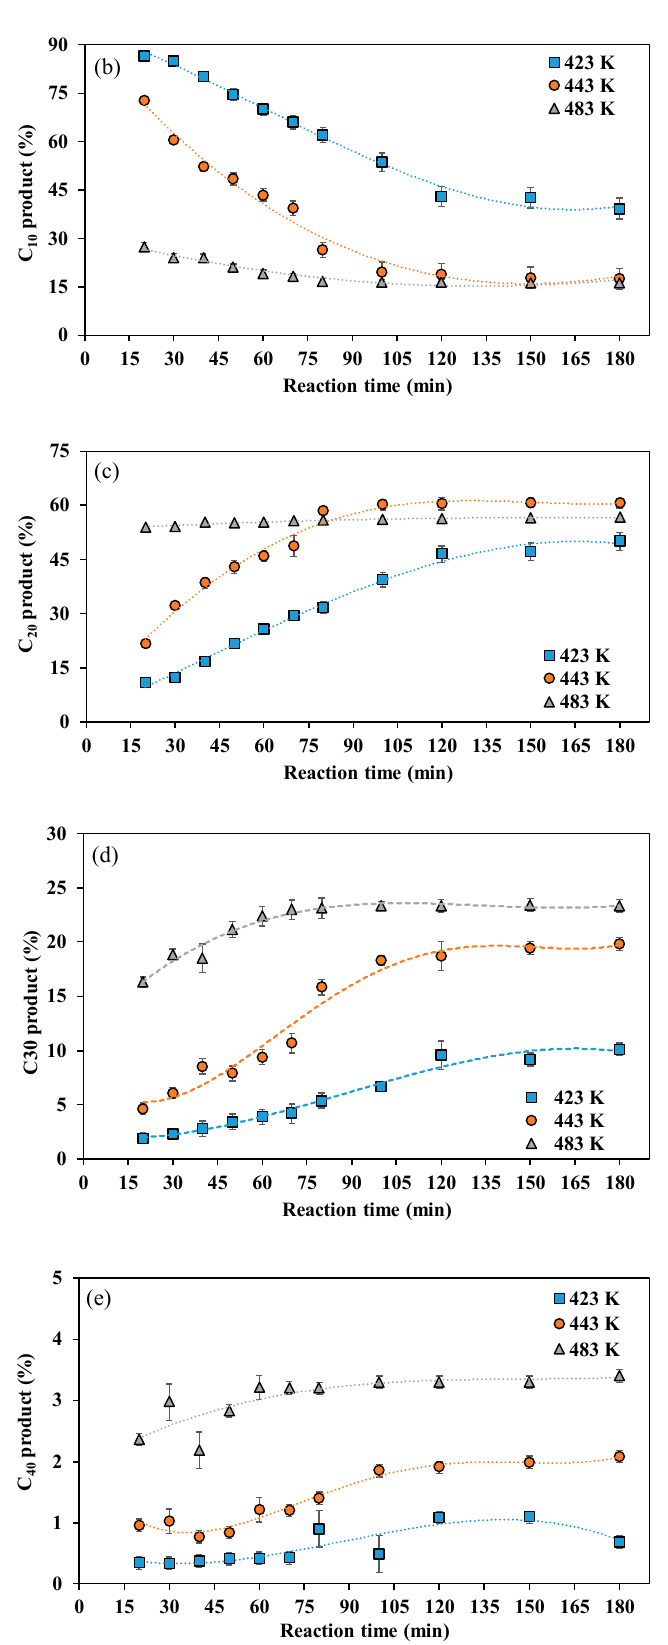
Figure 1. Effects of reaction temperature and reaction time on ( a ) 1-decene conversion; ( b ) C 10 content; ( c ) C 20 content; ( d ) C 30 content and ( e ) C 40 content (operating conditions: 50 mL 1-decene, 5 g HY catalyst and 1